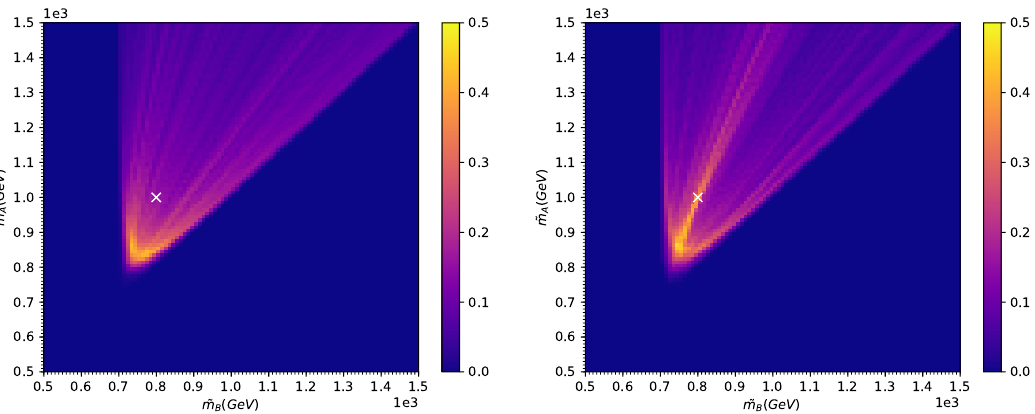
Figure 23 . The same as (cid:12)gure 16, for Standard Model dilepton t (cid:22) t background events (left panel) and preselected signal events (right panel), both for ~ m C = 700 GeV. The signal events entering the plot on the right have been preselected to obey all four kinematic endpoints (4.1) predicted for the Standard Model dilepton t (cid:22) t background. The white (cid:2) symbol marks the location ( m B ; m A ) of the true masses in the signal